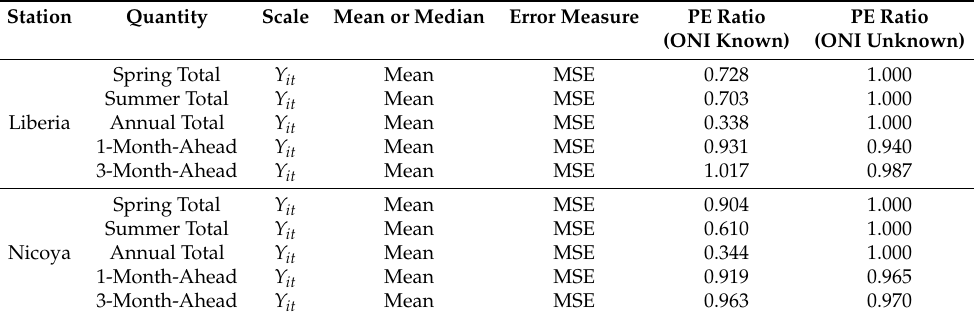
Table 6. Ratio of the prediction error (PE) based on the Tweedie model (where ONI may be assumed known or unknown) to that based on the naive method (sample means/medians by